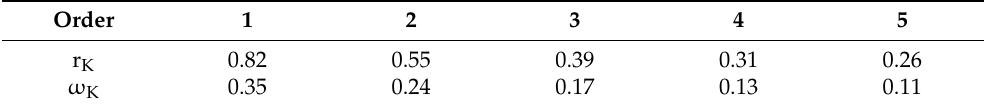
Table 6. Correlation coefficient and weight factor of each order.